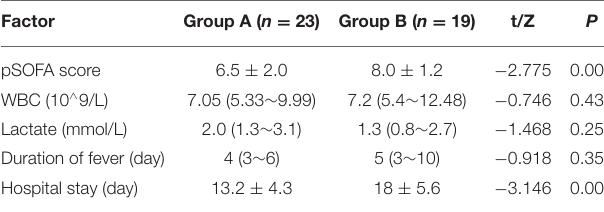
TABLE 3 | The mean duration of hospital stay in children with SOFA score of more than or less than 8.